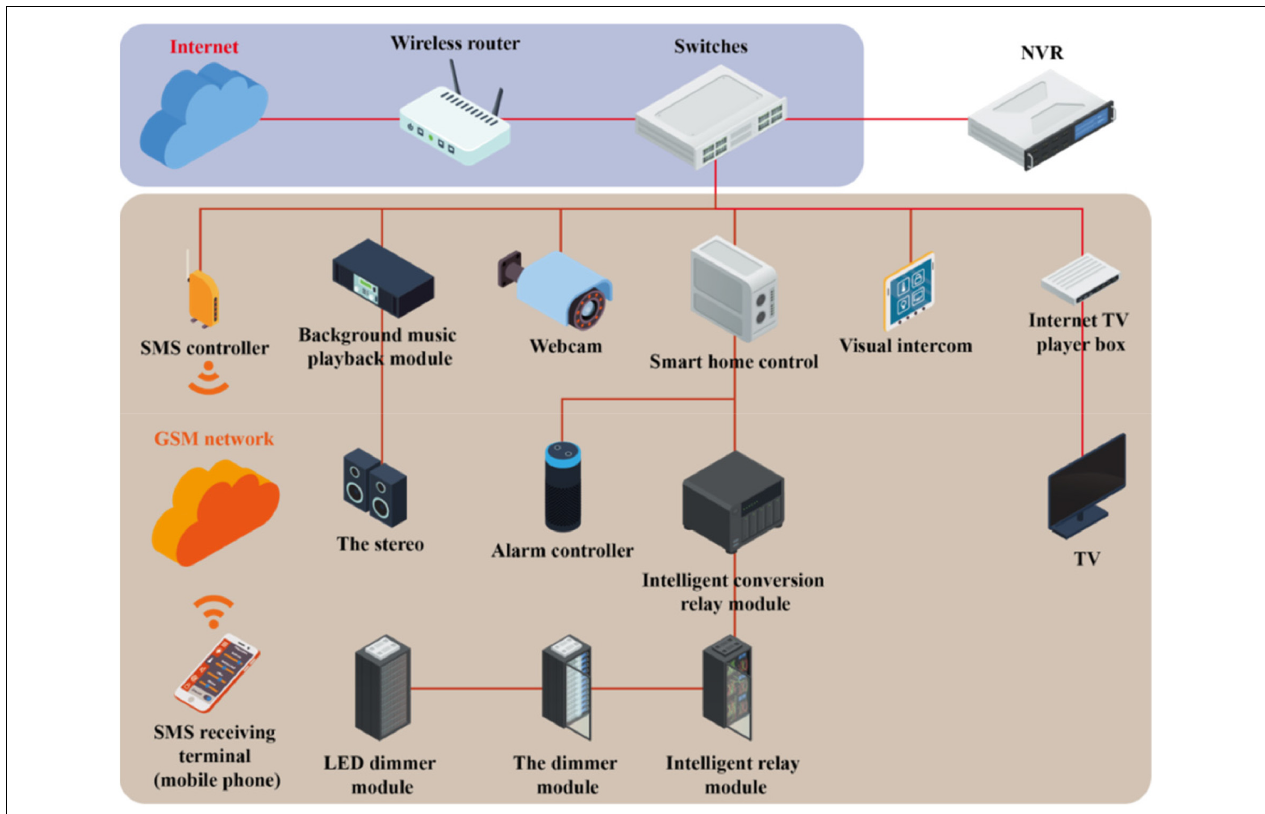
FIGURE 1 | Schematic diagram of the artificial intelligence interaction